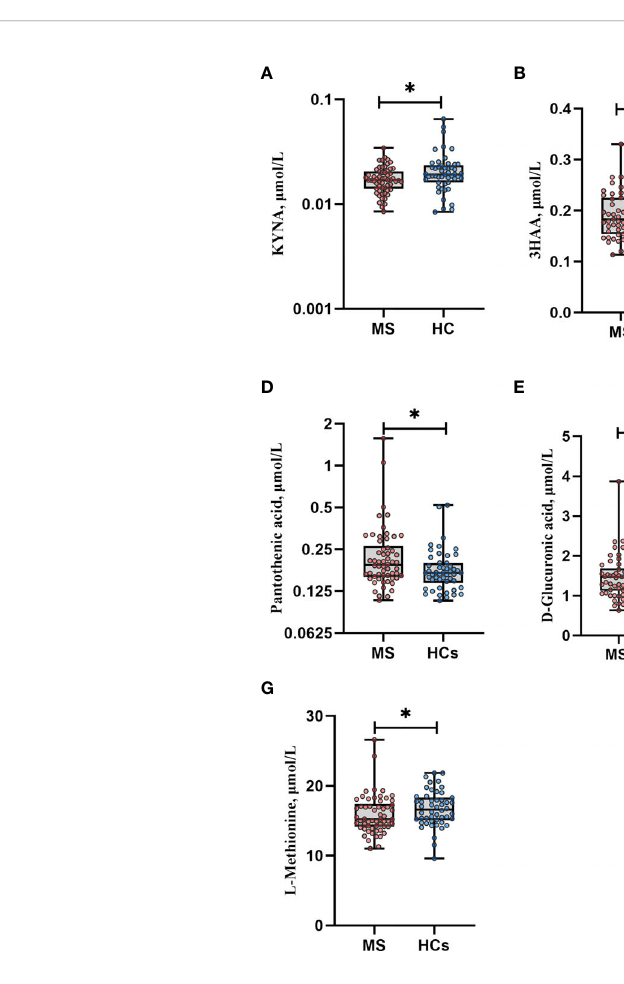
FIGURE 3 | Metabolites in multiple sclerosis (MS) vs . healthy controls (HCs). (A) KYNA levels were lower in MS vs . HCs. (B) 3HAA levels were higher in MS vs . HCs. (C – E) MS patients had higher levels of creatine, pantothenic acid and D-glucuronic acid compared with HCs. (F – G) Levels of valine and l-methionine were lower in MS patients vs. HCs. *p<0.05, **p<0.01 by Mann Whitney U test. Data are median (IQR), minimum and maximum. Each dot represents individual values. After adjustment for multiple testing all q values became non-signi fi cant, q>0.05. Due to right-skewed distribution, logarithmic scales were used to display KYNA